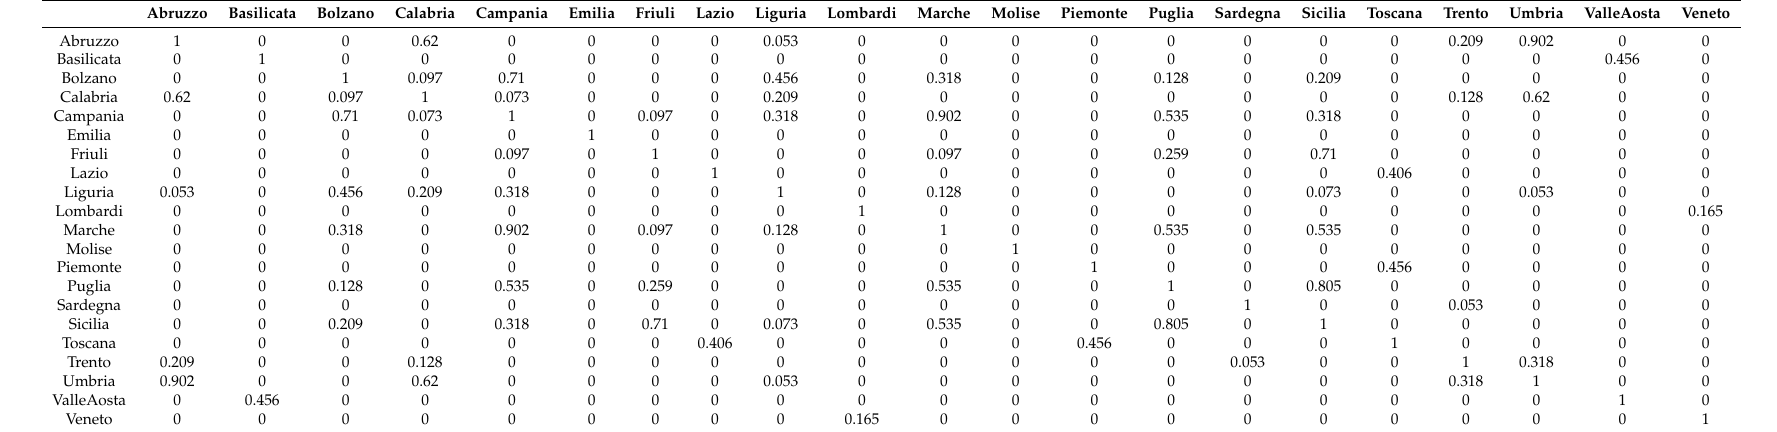
Table A60. Similarity values of Swabs network in the fifth